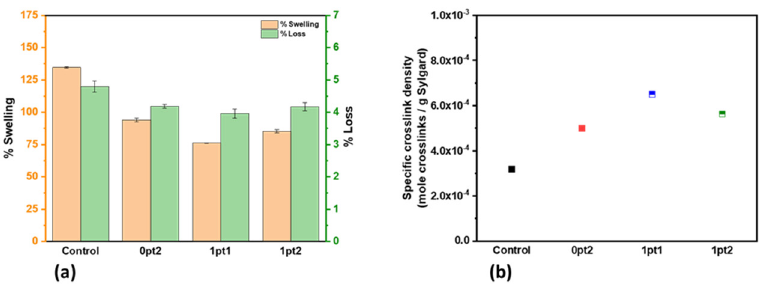
Figure 2. Solvent swelling experiments of pristine samples in toluene: ( a ) Swelling and loss percent for the formulations and ( b ) Specific crosslinking density 𝔭 𝑥 for the formulations.